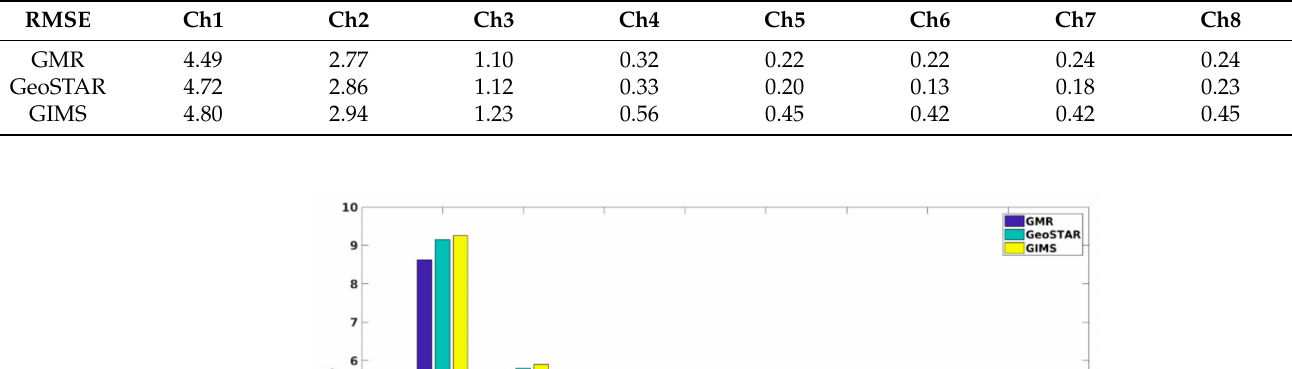
Table 5. RMSE(K) between the TB and the observation TA of GMR, GeoSTAR and GIMS.